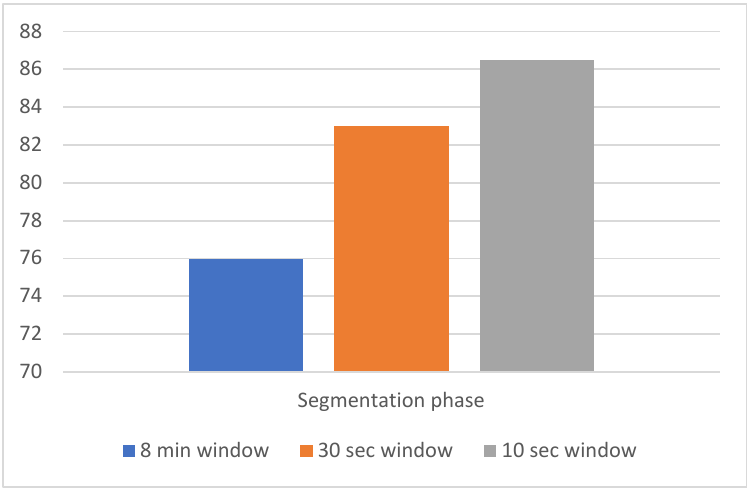
Figure 10. comparison of average accuracy for different k length windows . Figure 10. Comparison of average accuracy for different k length windows. Table 10. Comparative analysis study with previous state-of-the-art work in the same